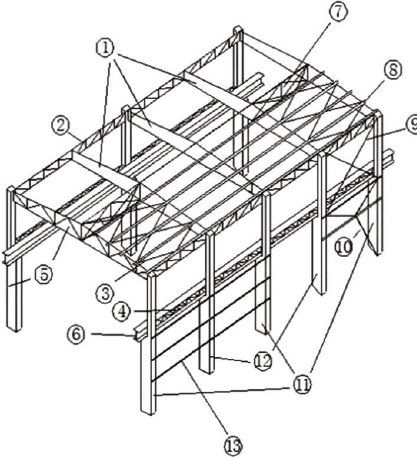
Figure 3: Three-dimensional model drawing of complex steel structure. Table 2: Experimental parameter